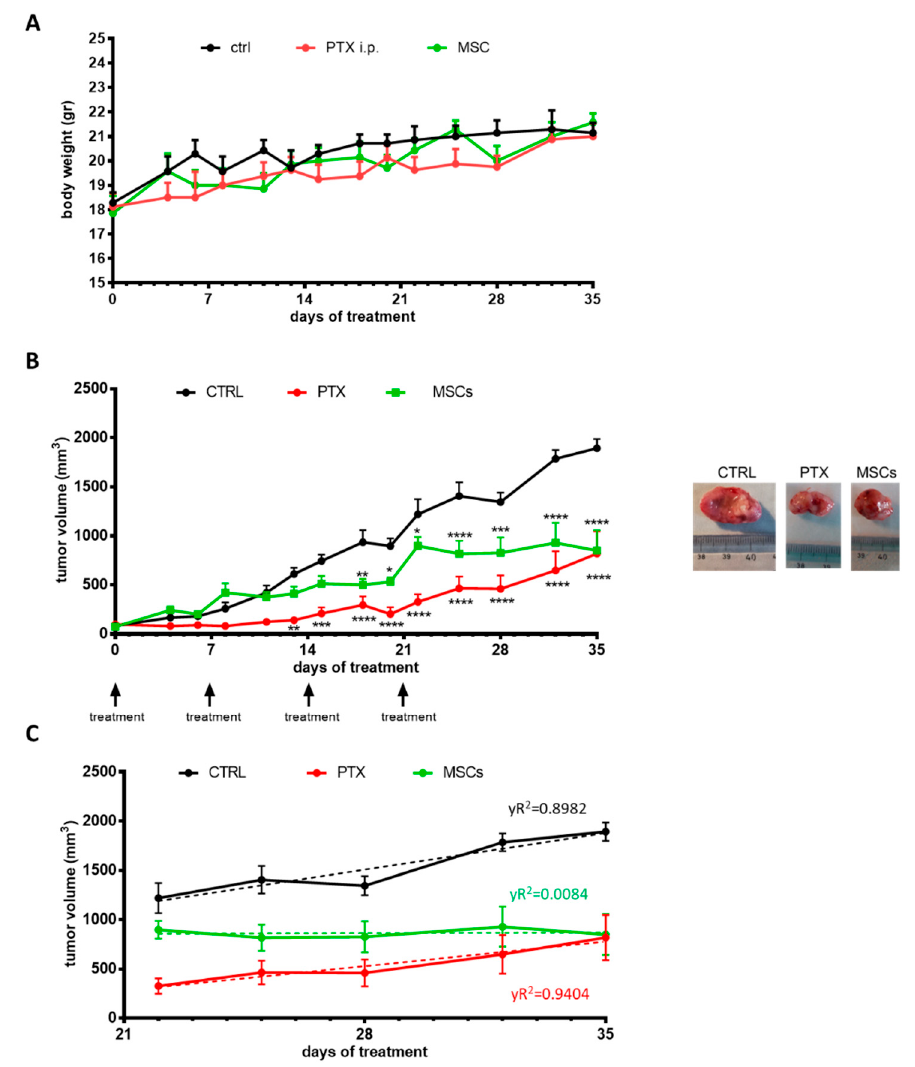
Figure 5. Effects of MSCs in MSTO-211H xenograft model. ( A ) MSTO-211H cells were subcutaneously inoculated into BALB/C nude mice, and after tumors had reached an average size of approximately 100 mm 3 , the animals were treated once a week (at days 0, 7, 14 and 21) with vehicle alone (CTRL), paclitaxel (20 mg/kg) or MSCs (5 × 10 6 ). ( A ) Mice body weight was monitored for the entire duration of the treatment. ( B ) Tumor volumes were measured twice per week and data are expressed as means of ± SEM. * p < 0.05, ** p < 0.01, *** p < 0.001, **** p < 0.0001 vs. CTRL. Representative images of dissected xenograft tumors are shown. ( C ) The graph shows the tumor growth during the 14 days after stopping treatments (from 22 to 35 days). Data are expressed as means ± SEM and for each group, the linear regression (dashed line) with R2 value is